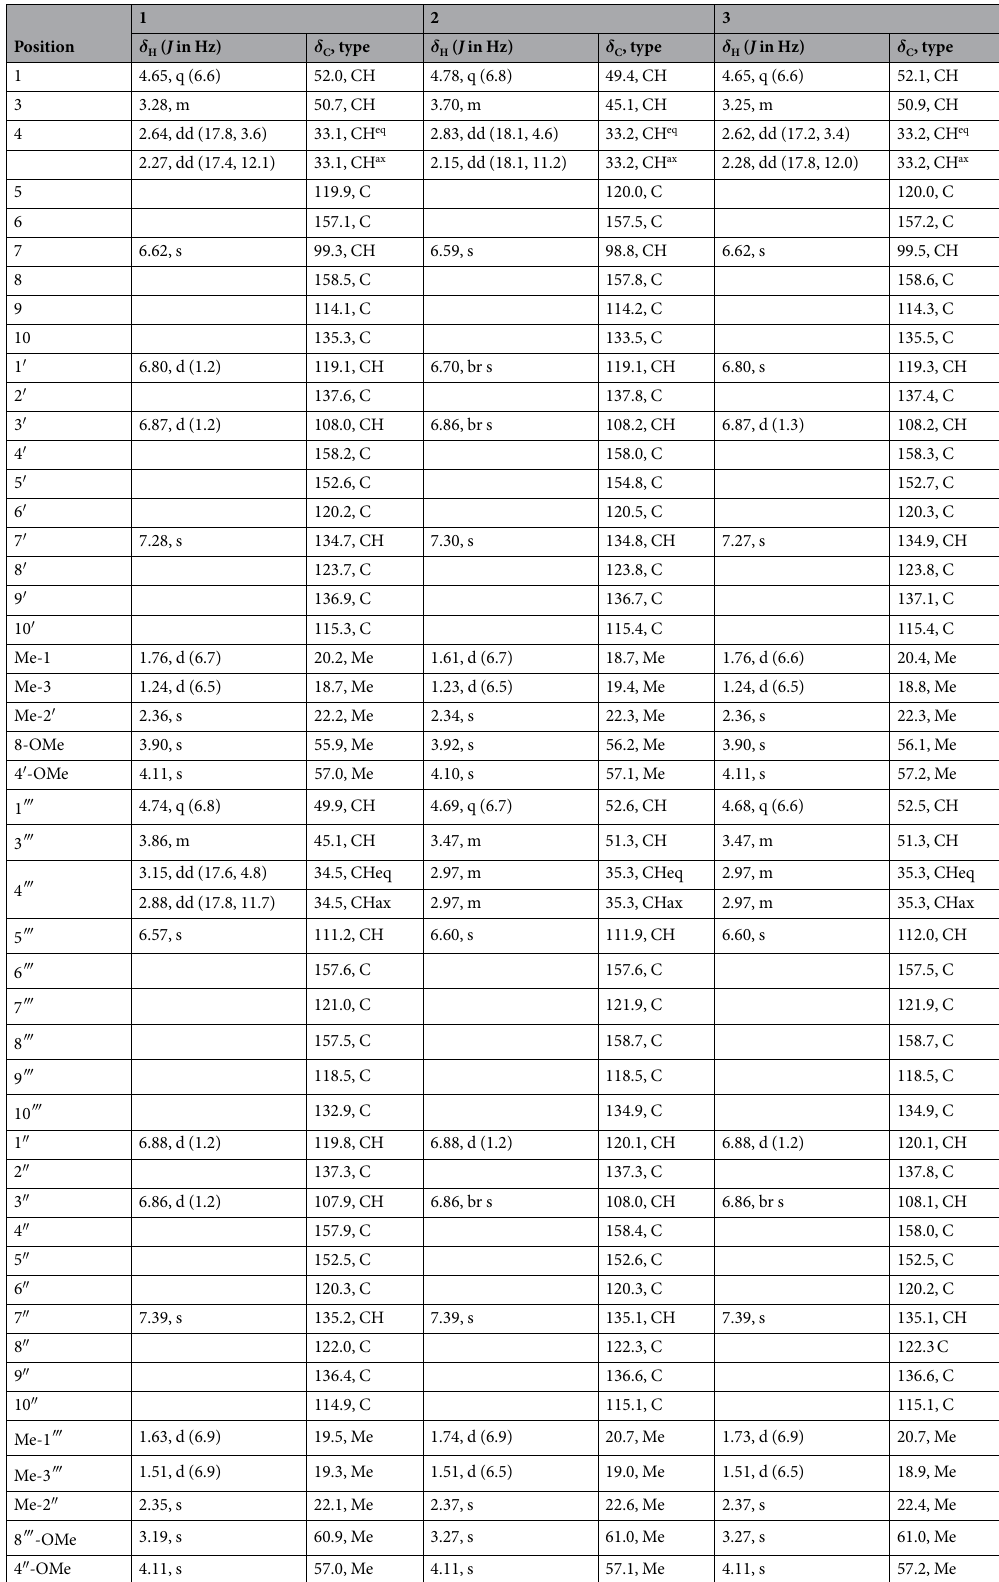
Table 1. 1 H (600 MHz) and 13 C (151 MHz) data of ealapasamines A–C ( 1 – 3 ) in Methanol-d4 (J in Hz, δ in